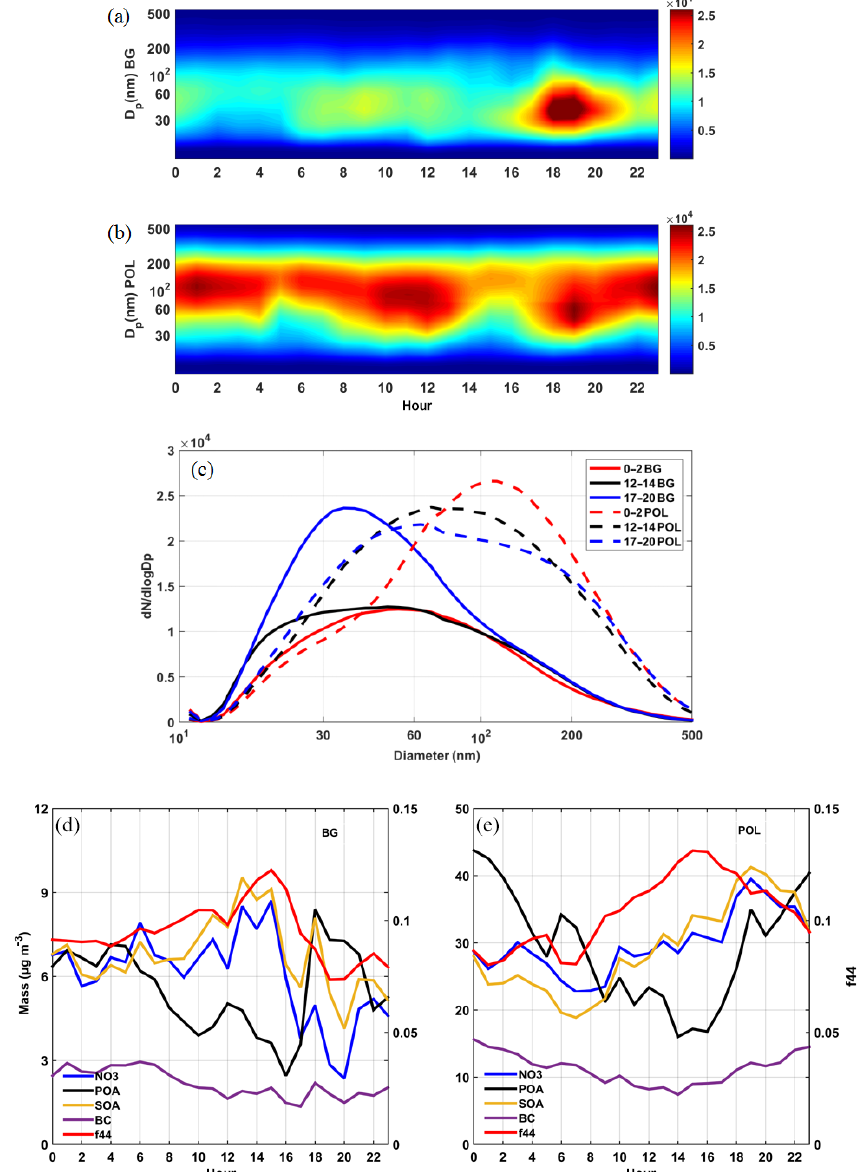
Figure 2. Diurnal variations in aerosol properties at the IAP site during the APHH field experiment, including the particle number size distribution measured by the SMPS under (a) background (BG) and (b) polluted (POL) conditions. (c) Mean particle number size distribution measured by the SMPS during three periods (00:00–02:00, 12:00–14:00, and 17:00–20:00LT) under BG and POL conditions. Bulk chemical component mass concentrations (NO 3 , POA, SOA, and BC) and f 44 made under (d) BG and (e) POL